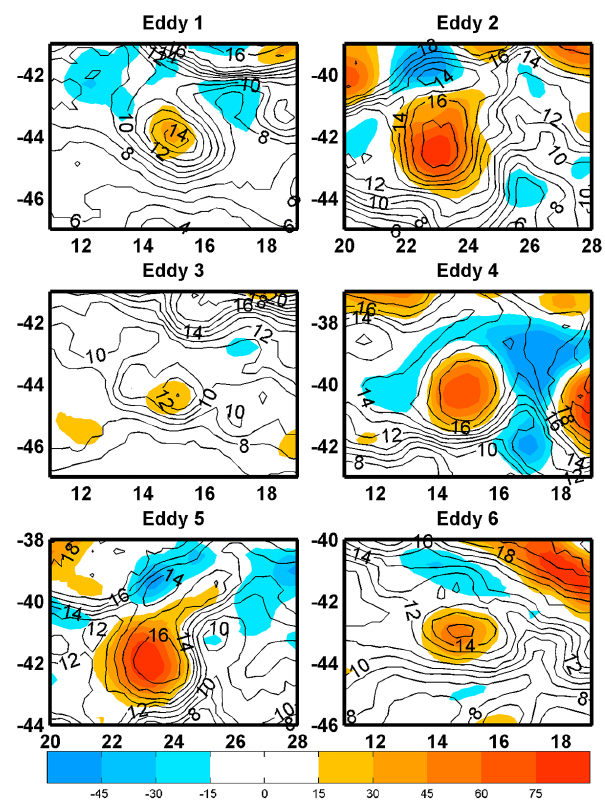
Figure 2. Mean weekly SST ( ◦ C) estimated from the AMSR-E and merged seal level anomaly (cm) for the six selected eddies. Times given correspond to weekly means centred at 10 July 2002 for Eddy 1, at 4 September 2002 for Eddy 2, at 19 March 2003 for Eddy 3, at 16 July 2003 for Eddy 4, at 3 September 2003 for Eddy 5 and at 5 May 2004 for Eddy 6. The SLA is in colour and SST contours are at every